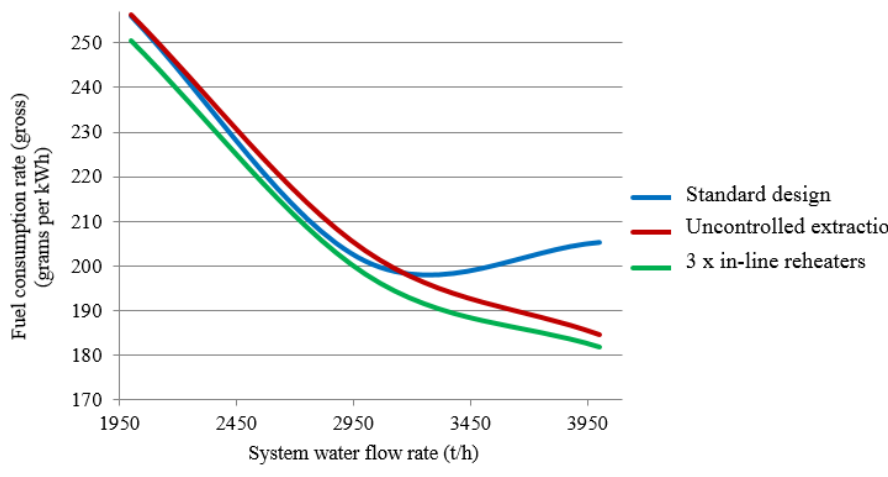
Figure 9. Plots of specific fuel-equivalent flow rates as a function of the system water flow rate for generating unit thermal systems at an outdoor air temperature of −5 °C.